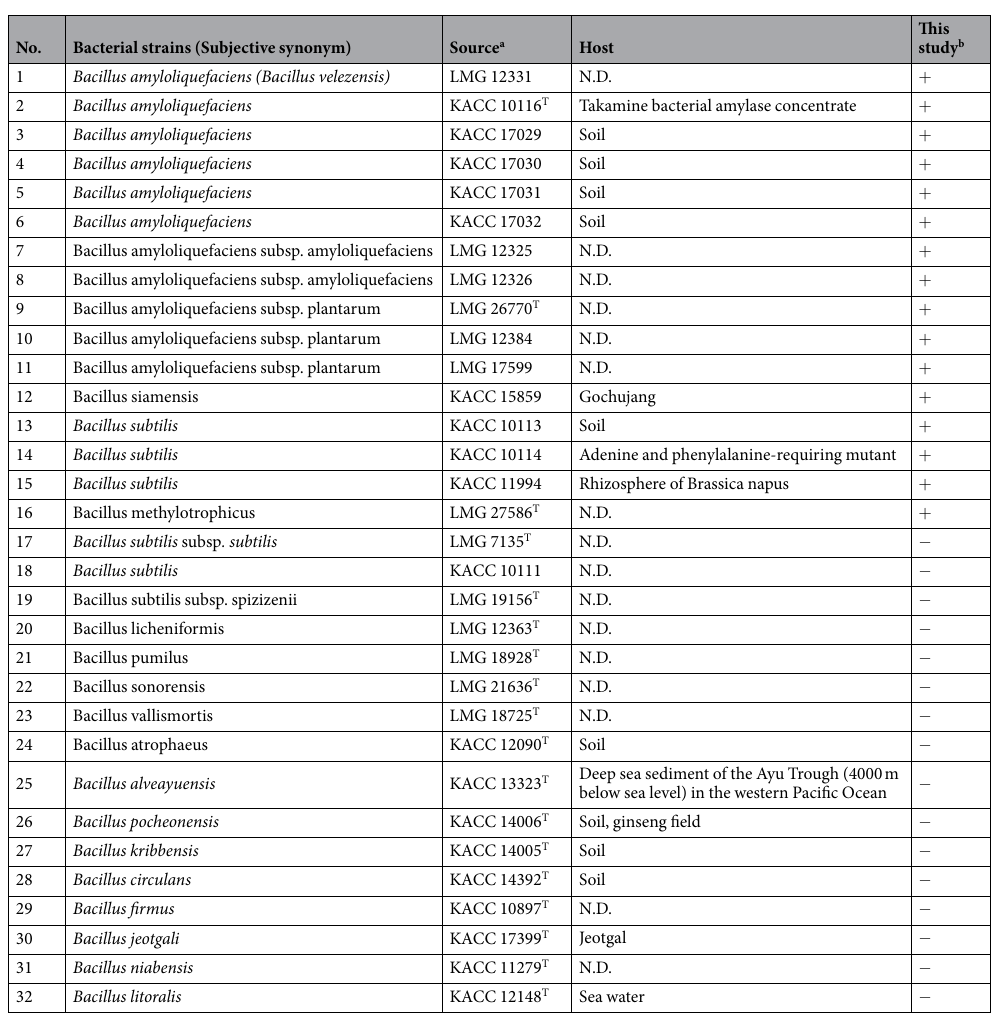
Table 2. Bacterial strains used in the PCR specificity test for Bacillus velezensis . a Superscript “T” indicates type strain. b Conventional or real-time assay; + and − indicate species detected or not detected, respectively. c N.D., Not